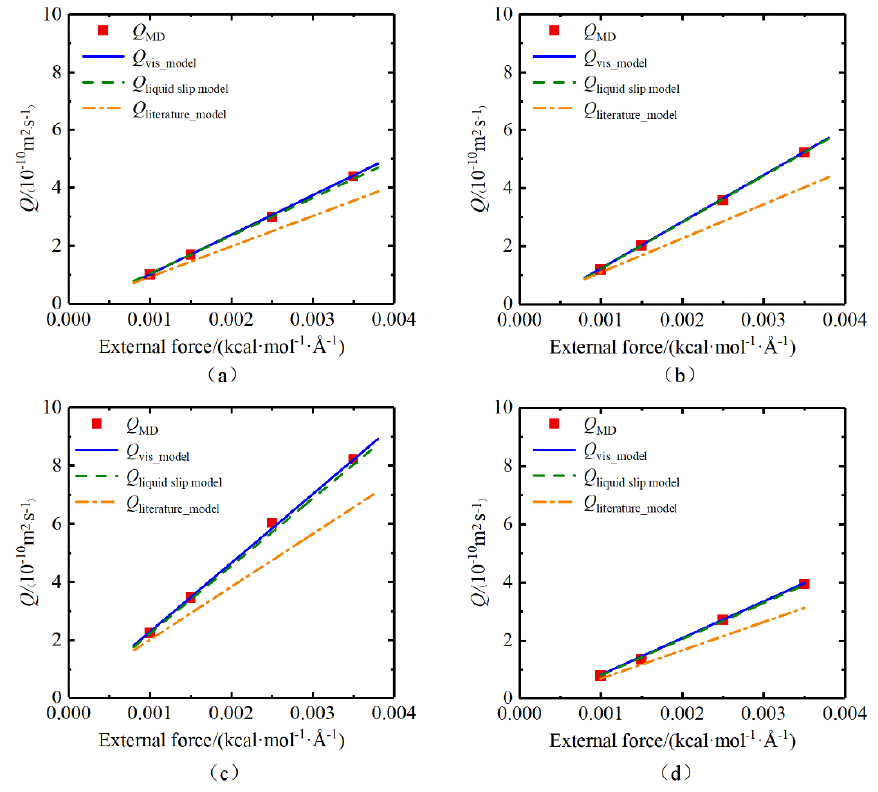
Figure 14. The comparison of oil flow rate computed by various mathematical models with molecular simulation data: ( a ) 5 nm quartz slit with OMP = 50%; ( b ) 5 nm quartz slit with OMP = 60%; ( c ) 10 nm quartz slit with OMP = 40%; ( d ) 5 nm calcite slit with OMP = 60%.